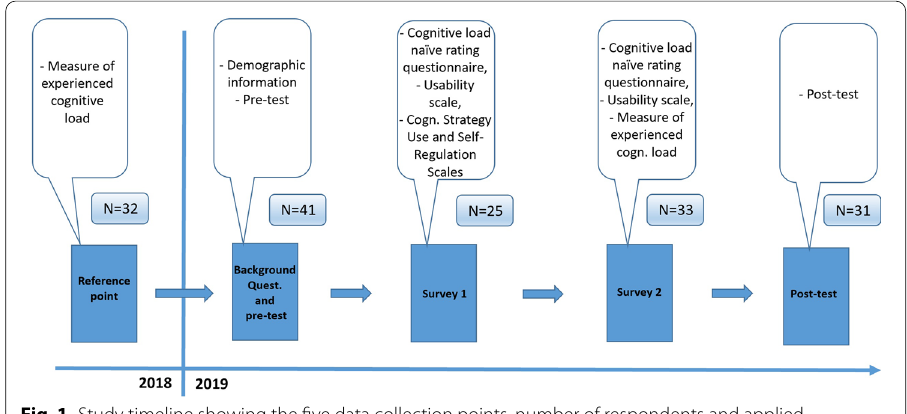
Fig. 1 Study timeline showing the five data collection points, number of respondents and applied